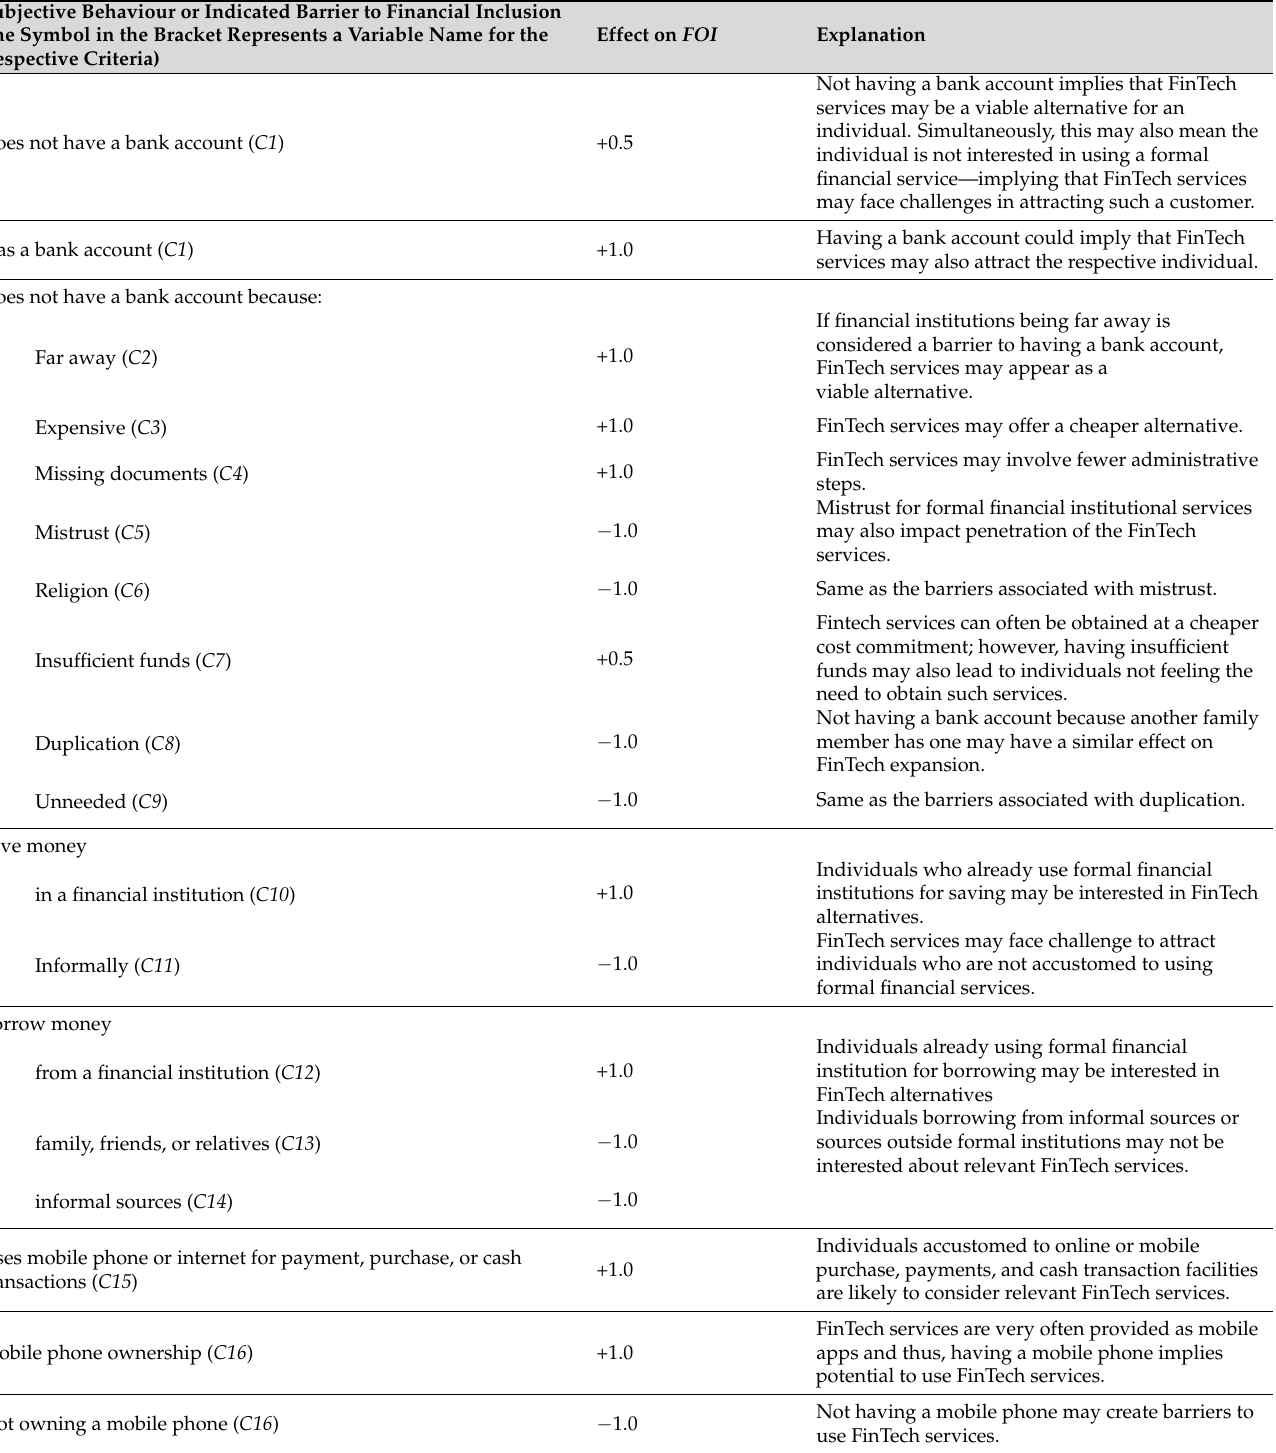
Table 2. FOI calculation and